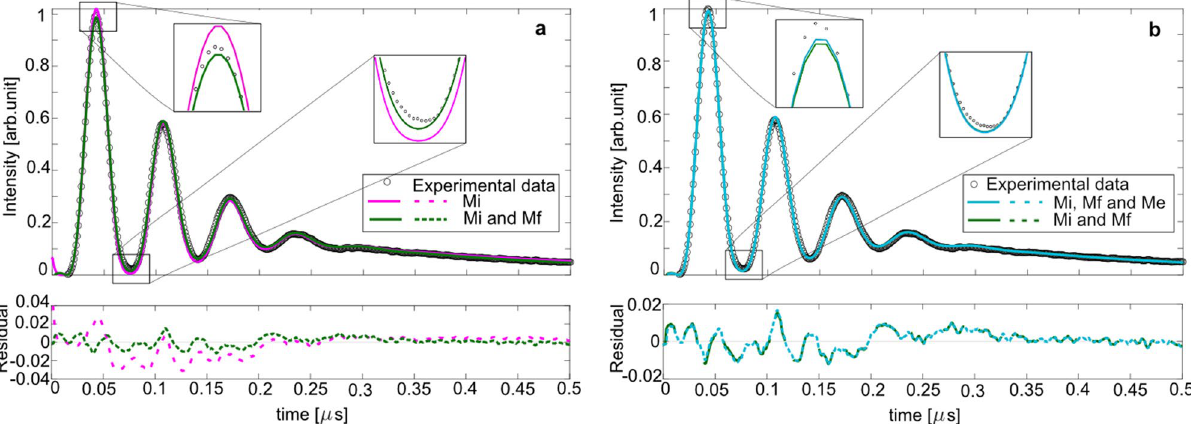
Figure 6. Measured, at 700 µ J laser pulse energy, and modelled LIGS signals of N 2 at 323 K . The modelled signals are based on Eq. (3). ( a ) Pink curve corresponds to the model containing only the instantaneous term ( M i ) and the green curve is the model where both the instantaneous and finite terms ( M i and M f ) are included. ( b ) Green curve corresponds to the model containing both the instantaneous and finite terms ( M i and M f ), while the blue curve shows the model containing the instantaneous, finite and electrostrictive terms ( M i , M f and M e